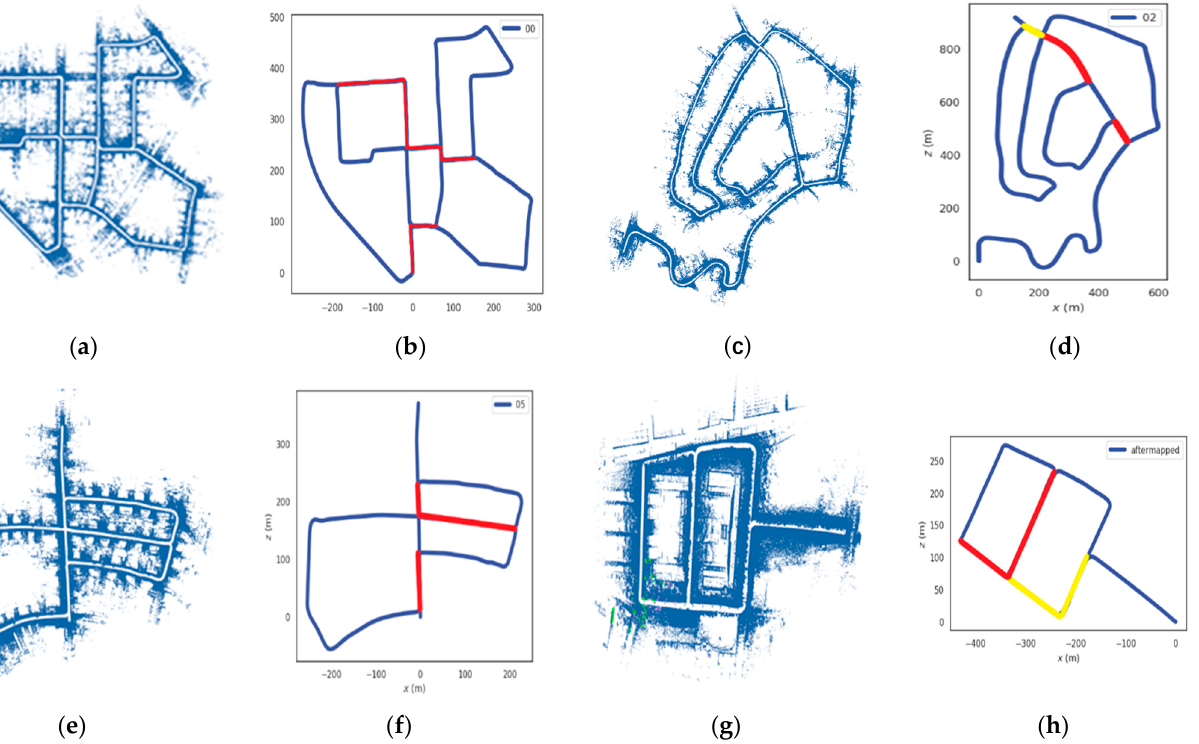
Figure 8. Mapping and LCD results should be listed as the ( a – f ) mapping and LCD results on KITTI-00, KITTI-02, and KITTI-05; ( g , h ) mapping and LCD results on jlu00. The red and yellow lines indicate the detected obverse and reverse loop closures, respectively.